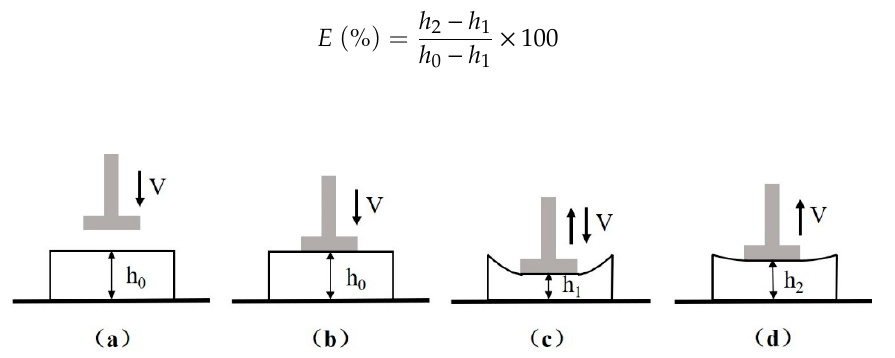
Figure 2. Diagram of the compression test process: ( a ) initial state, ( b ) presser contact with sample, ( c ) presser drop at lowest position, ( d ) final state.